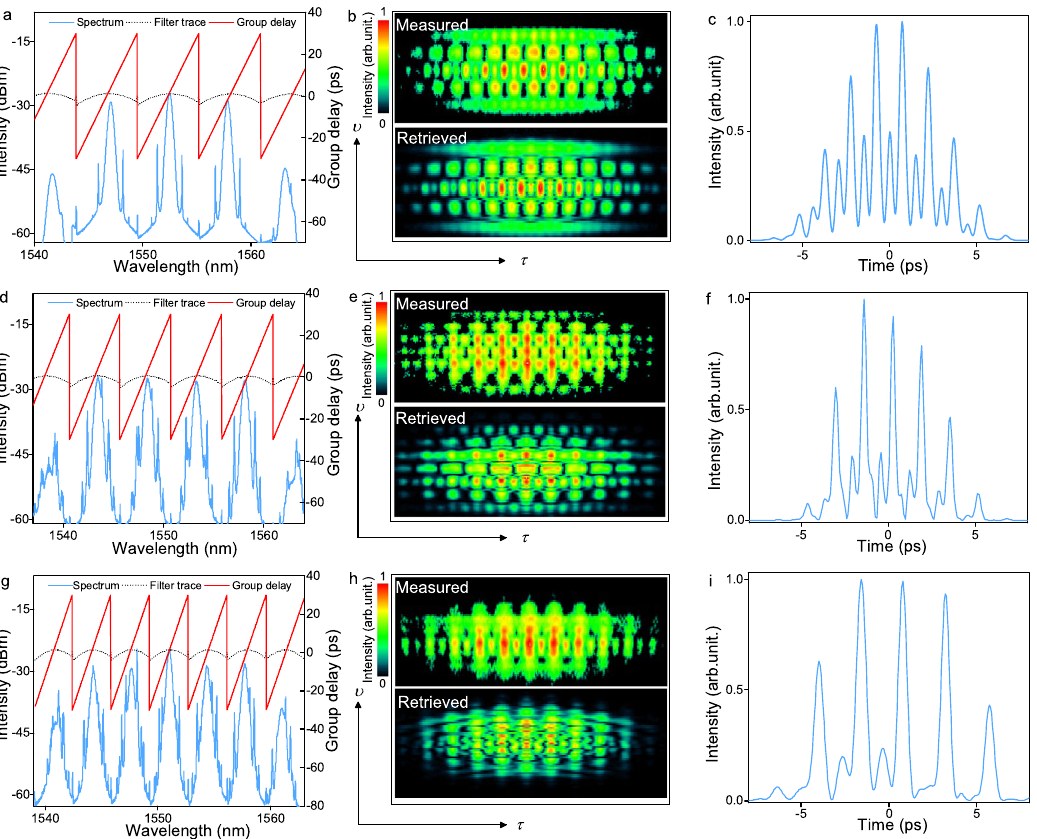
Fig. 5 Synchronized three- to fi ve-wavelength mode-locking of soliton fi ber lasers. Spectra, FROG spectrograms, and retrieved pulse pro fi les of a – c three-, d – f four-, and g – i fi ve-wavelength mode-locked solitons,